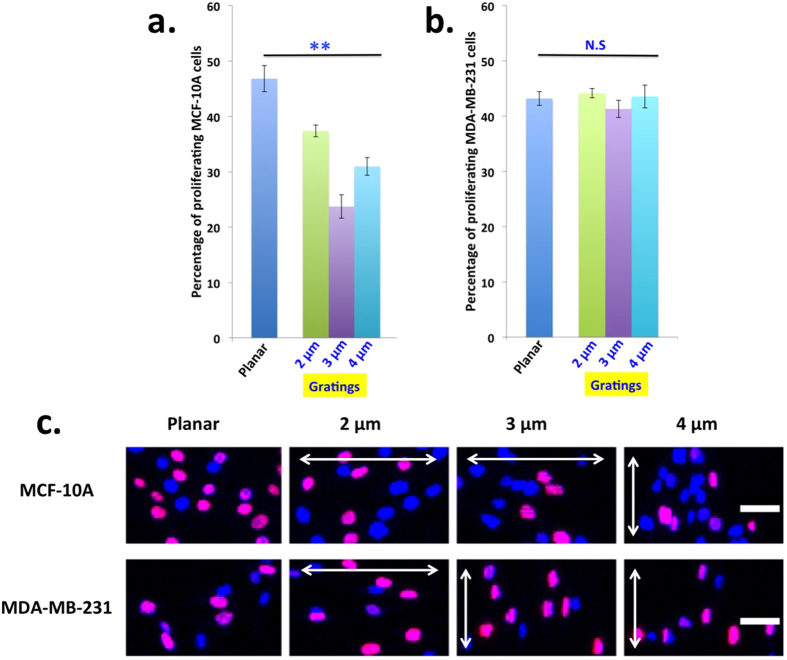
Microgratings reduces proliferation of non-cancer epithelial but not of metastatic breast cancer cells.(a) MCF-10A proliferation decreases on different dimensions of microgratings coated with collagen after 24 hours of cell seeding. Data are means ± s.e.m. (n = 3). For each experiment, 300 cells were considered on an average. P values were obtained using Student’s unpaired t-test. **p < 0.01 with respect to planar. (b) Topographical cues do not affect MDA-MB-231 proliferation. N.S. denotes non-significant with respect to planar. (c) Confocal microscopy representative images of proliferating MCF-10A and MDA-MB-231 cells cultured on different topographic patterns; DAPI: Blue, EdU: Red. Double-sided arrow indicates the direction of the grating axis. (Scale 50 μm)